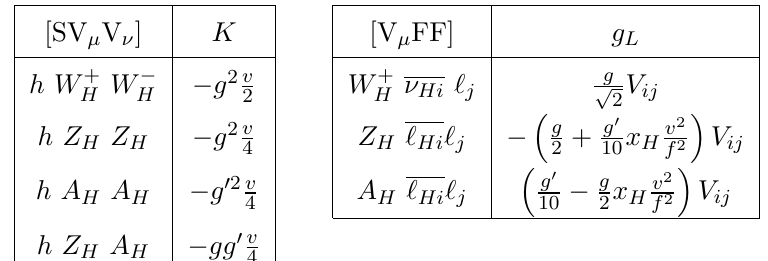
. (The coupling (cid:8) ++ ~ ‘ c ‘ j does not i c W